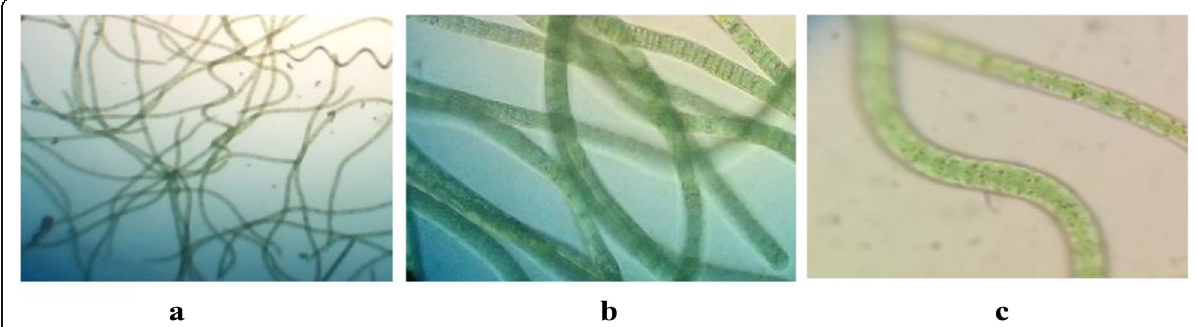
Fig. 1 Light microscopic observation of Spirulina platensis . a Magnification × 10. b Magnification × 40. c Magnification ×